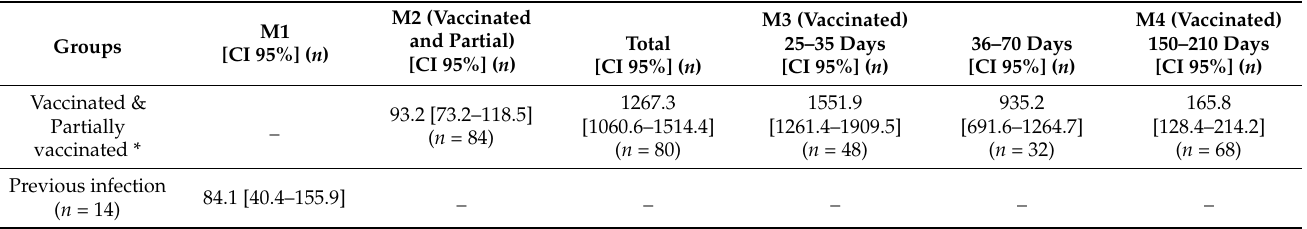
Figure 2. Concentration of neutralizing antibodies (nAb) titers (logarithmic scale 10) reported in the box-whisker plots (and outliers) for individuals with previous infection and vaccinated individuals without previous infection for the four different moments of observation. Table 4. Geometric Mean (GM) of neutralizing antibodies (nAb) titers at four different moments for the full-vaccinated, partially vaccinated participants and at moment of recruitment for individuals with previous